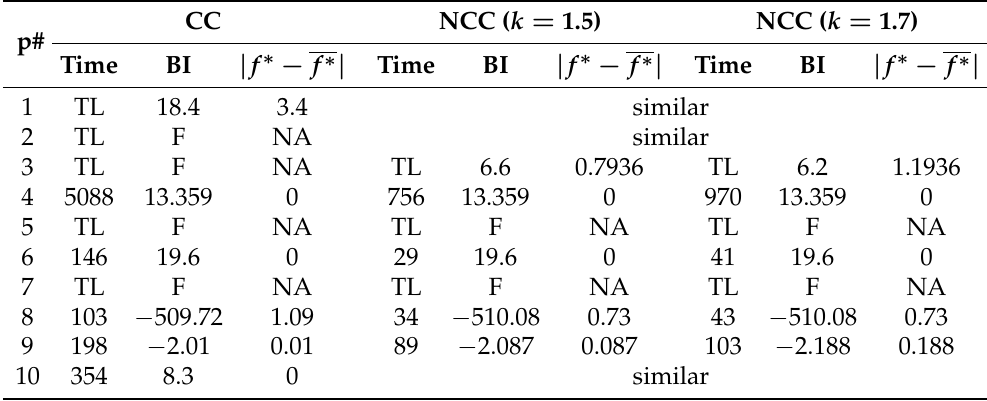
Table 10. Results of solving MILP problems produced with LOG and NLOG models using 11 break-